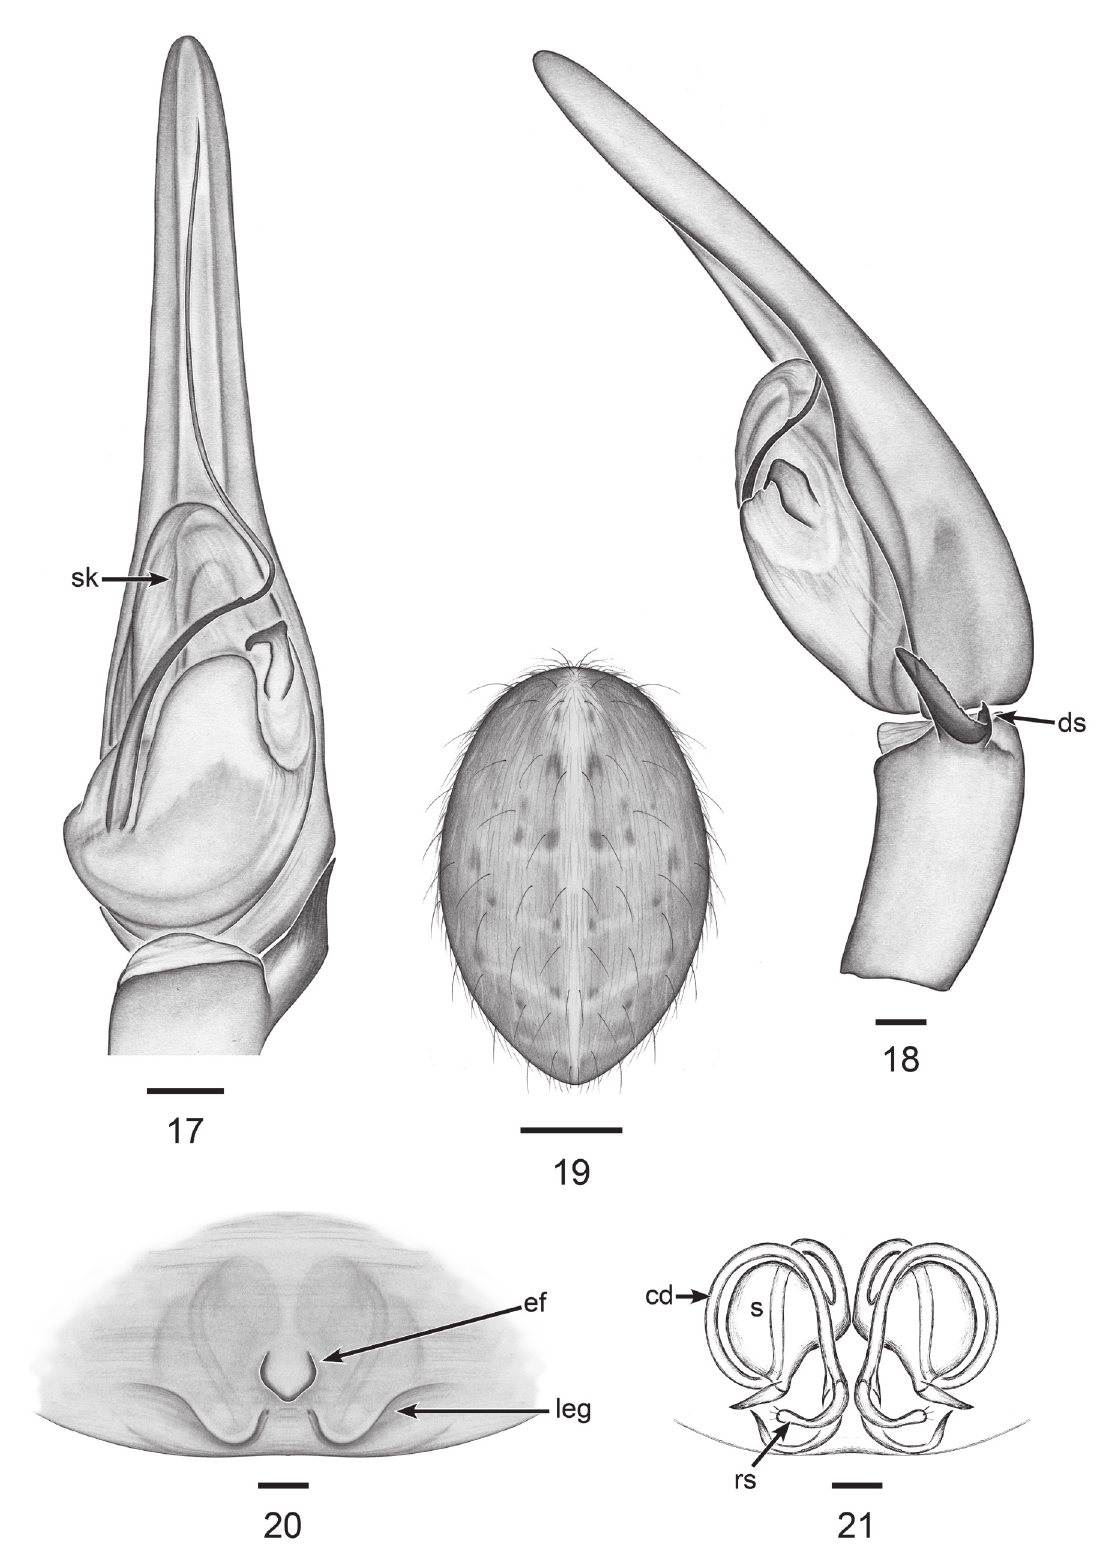
Figs 17–21. Katissa yaya sp. nov. 17 . ♂, palp, ventral view. 18 . ♂, palp, retrolateral view. 19 . ♀, abdomen, dorsal view. 20 . ♀, epigynum, ventral view. 21 . ♀, internal genitalia, dorsal view. Scale bars: 17–18, 20–21 = 0.1 mm; 19 = 1